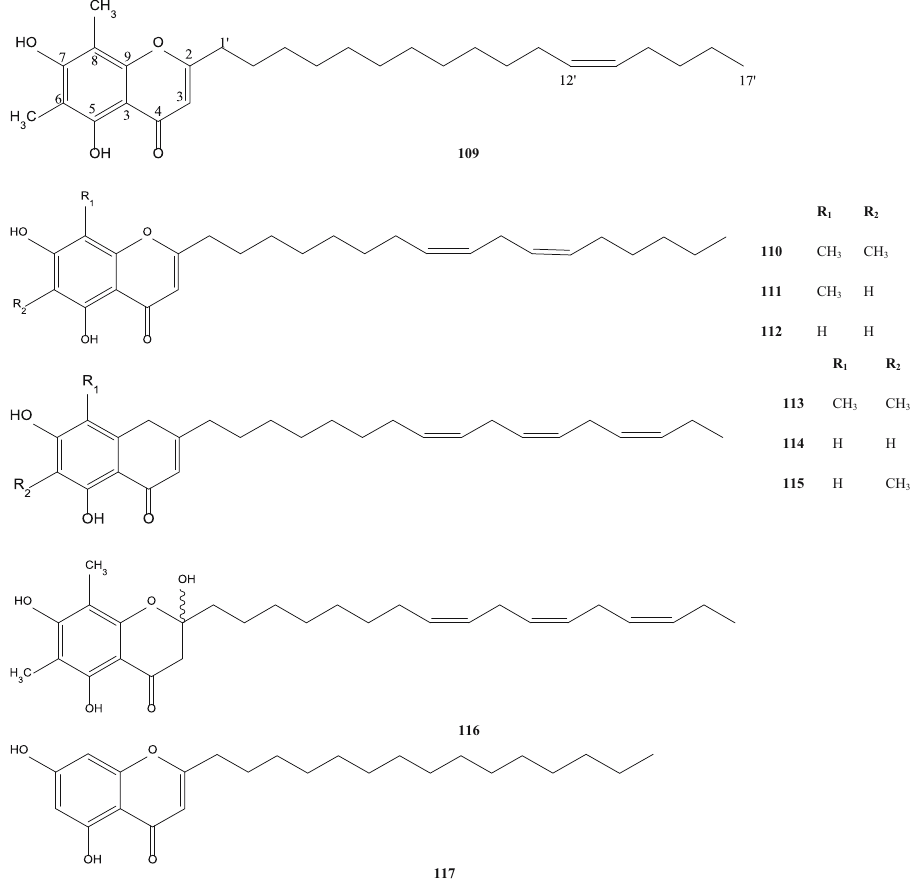
Figure 10: Acylphloroglucinol derivatives from S. samarangens